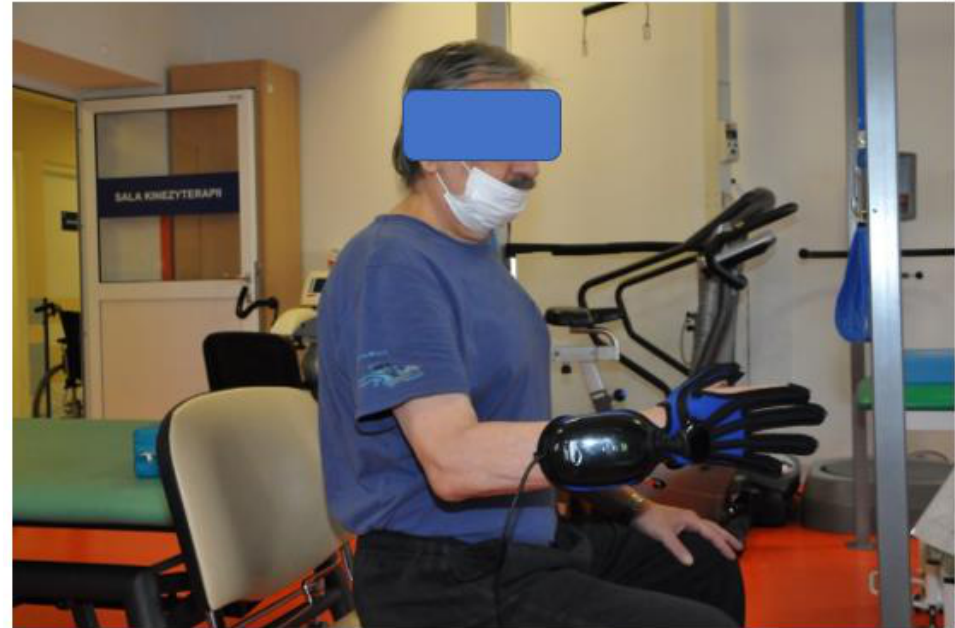
Figure 2. Patient in a sitting position without back support, feet on the floor, upper limb against the body (i.e., abduction in the shoulder joint and elbow flexion in an intermediate position).